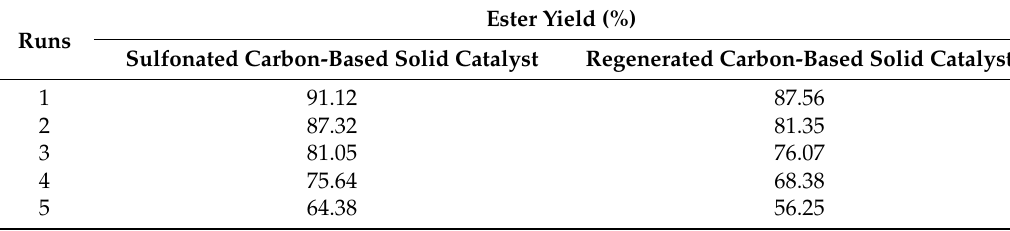
Table 3. Recycling and regeneration performance of the sulfonated carbon-based solid catalyst.